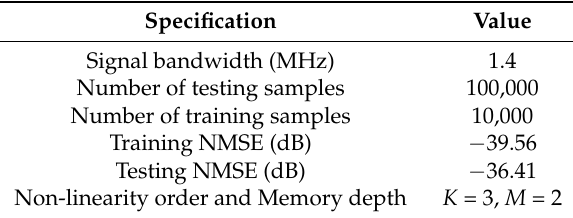
Table 5. Summary of the performance evaluation of the branch-by-branch, digital combining, mixer-less three-way amplitude modulator-based transmitter.